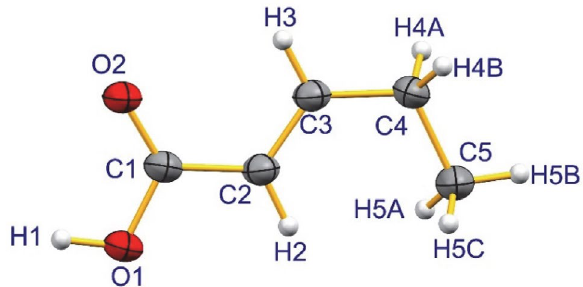
Figure 1: A view of the asymmetric unit of the compound C 5 H 8 O 2 with the atom-numbering